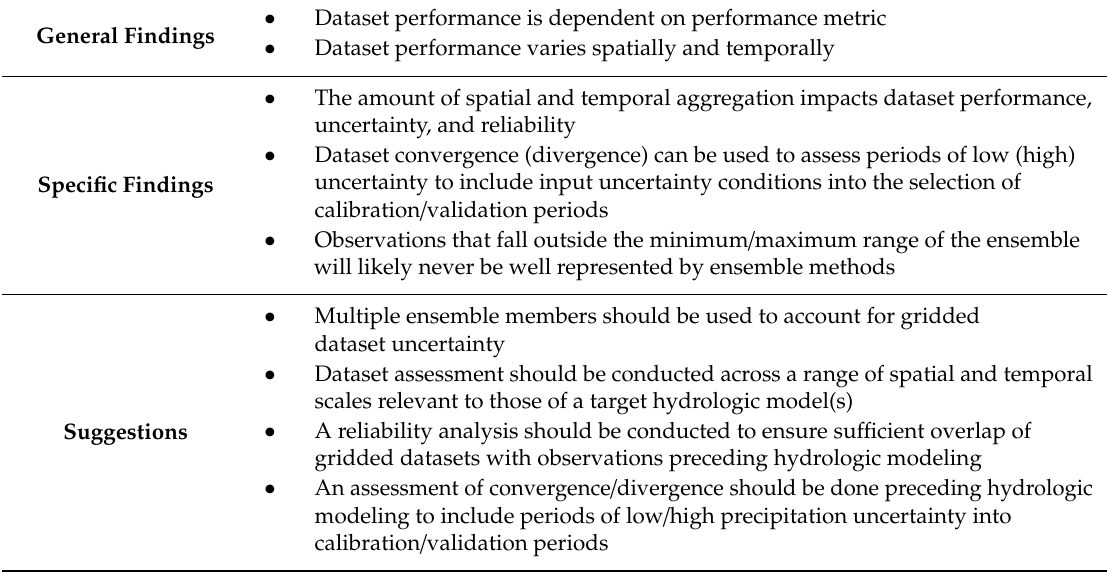
Table 3. Summary of findings and